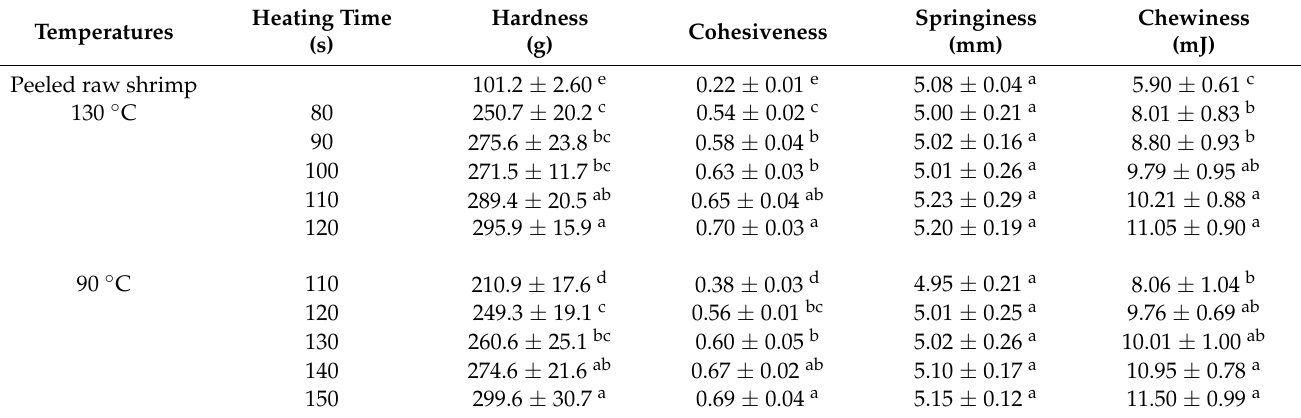
Table 4. Values of texture properties in peeled white shrimp using the scaled-up MAIH system set at 130 ◦ C and 90 ◦ C for various heating